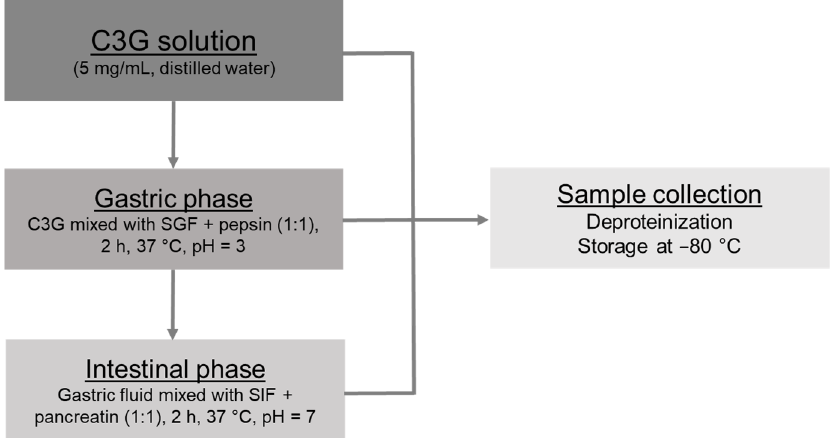
Figure 1. Flow diagram of the in vitro digestion protocol. C3G: Cyanidin-3- O -Glucoside; SGF: Simulated Gastric Fluid; SIF: Simulated Intestinal Fluid.